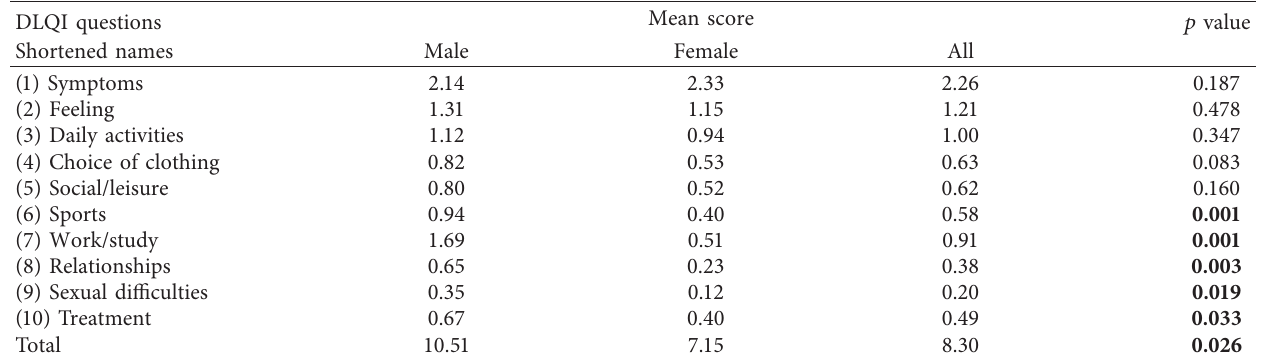
Table 1: The mean DLQI scores for each item (questions) and their comparison with the gender Mann–Whitney U -test ( p value).